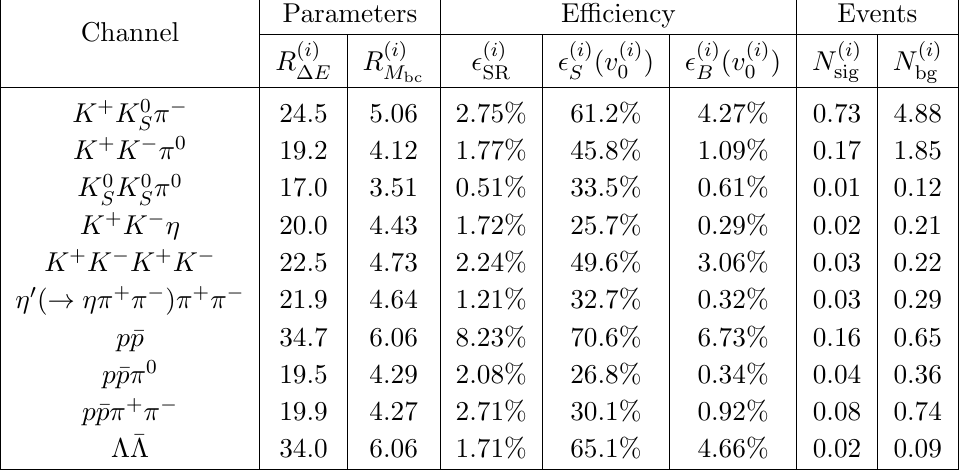
. (cid:17) c 2 (1 D ) K 0 S ! ( B + ( (cid:17) (1 D ) (cid:17) c 2 (1 D ) K + ) c 2 B ! (cid:2) B ! (cid:17) c 2 (1 D ) K + and B 0 (cid:17) c 2 (1 D ) K 0 . ! ! ( R ( i ) ) are in MeV (MeV =c 2 ); all other values are (cid:1) E M bc